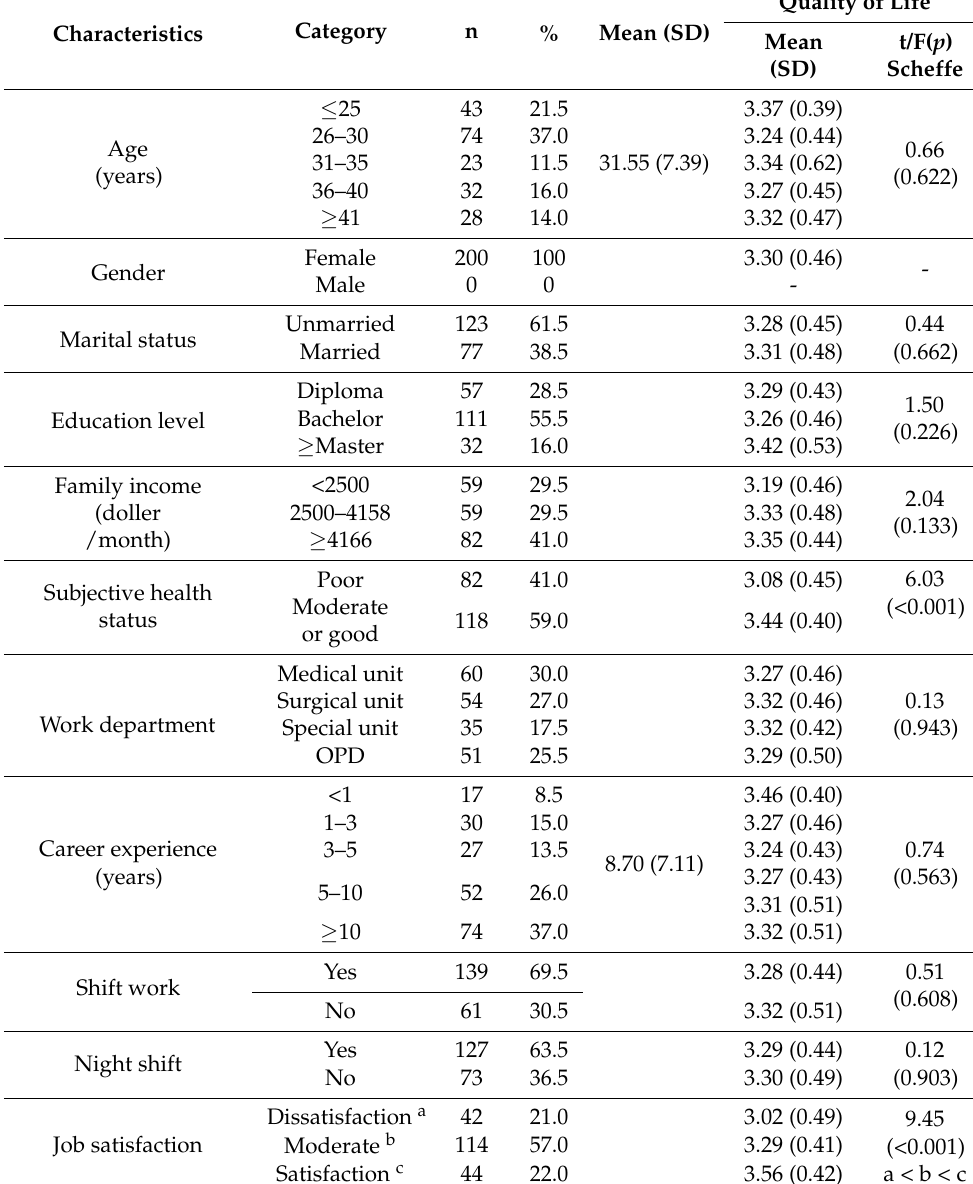
Table 1. Quality of life based on general characteristics ( N =